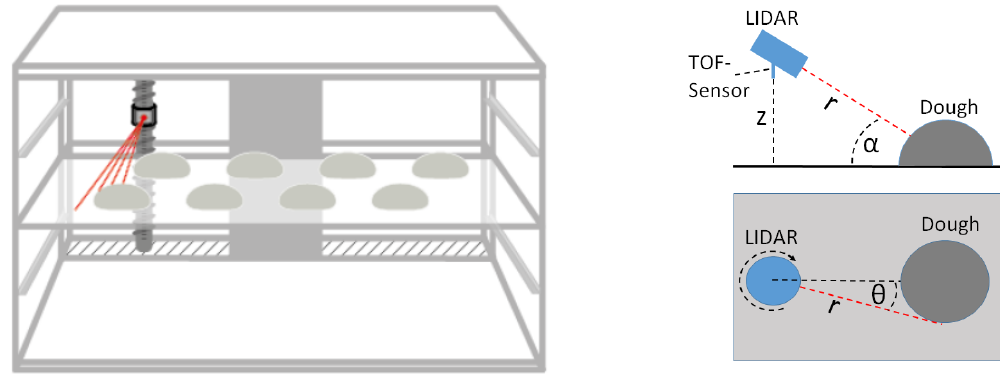
Figure 4. Test setup (left) and schematic (right).